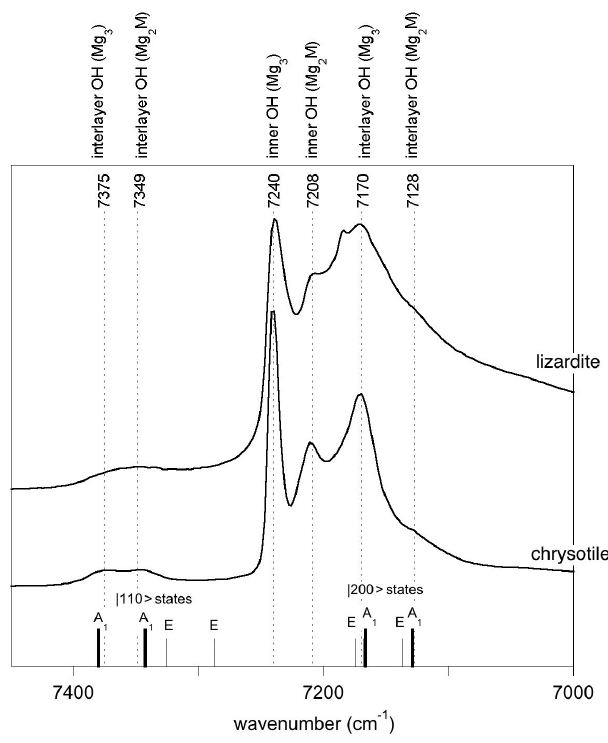
Figure 3. Assignment of OH overtone transitions in serpentine group minerals. Transitions calculated for a molecular cluster are in- dicated by the vertical bars labelled with the corresponding excited state (Table 3). The thick vertical bars denote an expected stronger absorption intensity due to the symmetry of the excited state. Note the bands related to the occurrence of divalent cations (M = Fe 2 + and/or Ni 2 + ) substituting for Mg in the tri-octahedral sheet of ser- pentine group